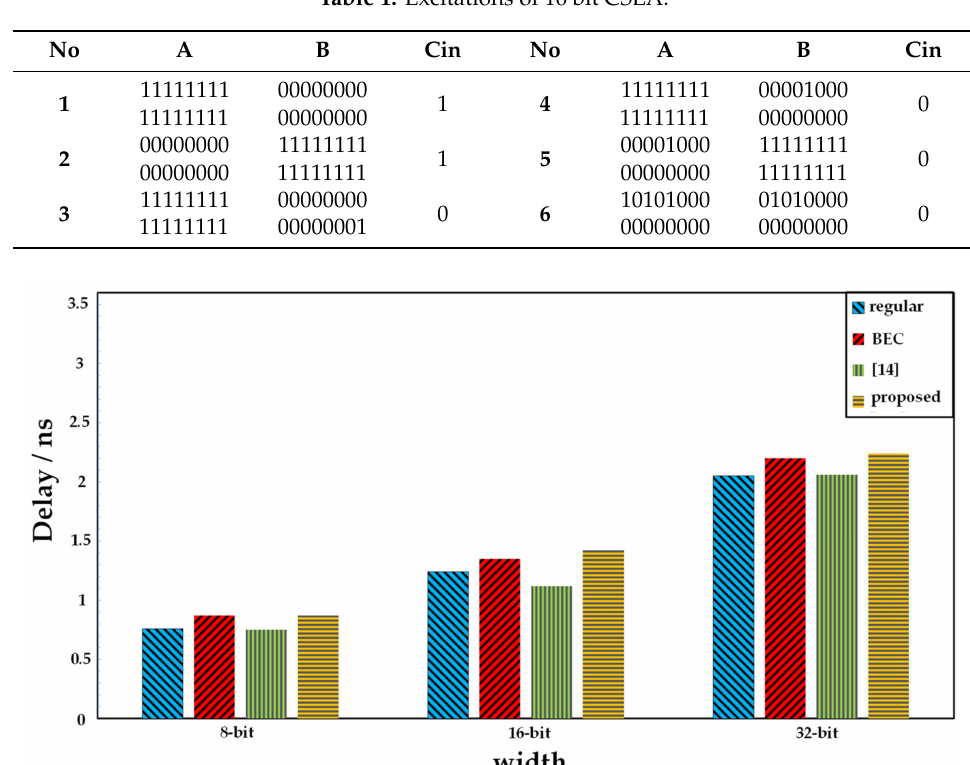
Figure 8. Delay comparison among the four types of